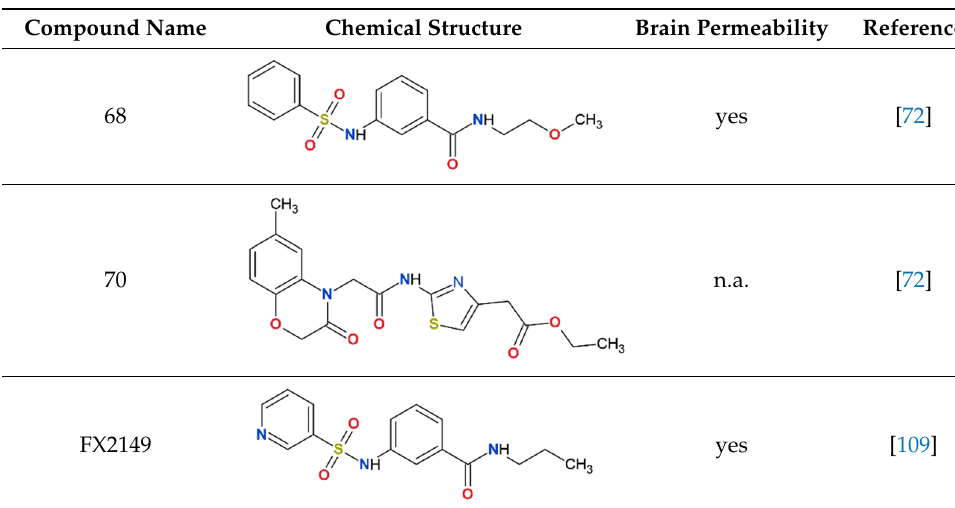
Table 3. LRRK2 GTPase inhibitors developed to date.